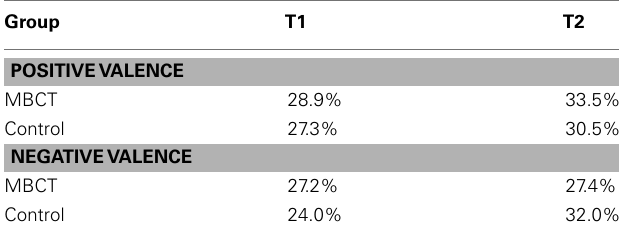
Table 2 | Mean percentage of recalled words by valence category, treatment group, and time point.